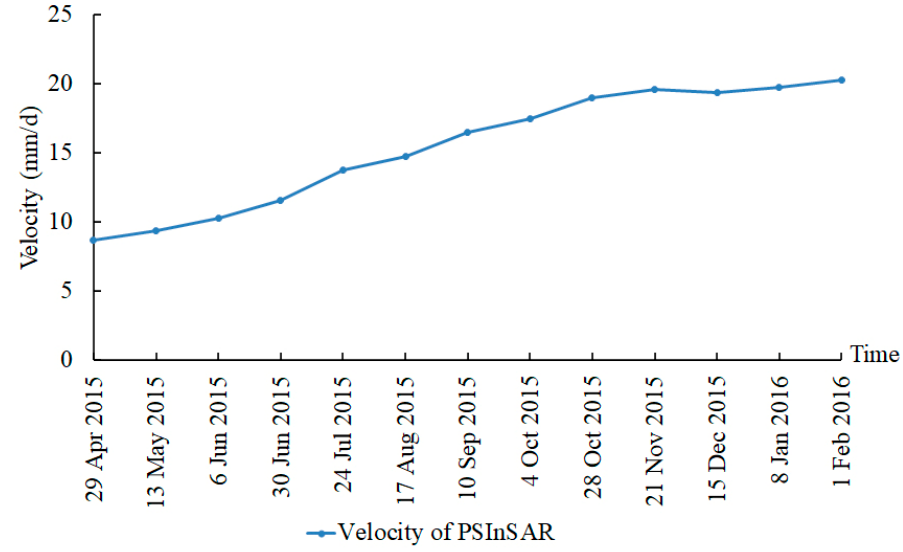
Figure 13. Velocity of the Jinpingzi landslide based on the PSInSAR technique.